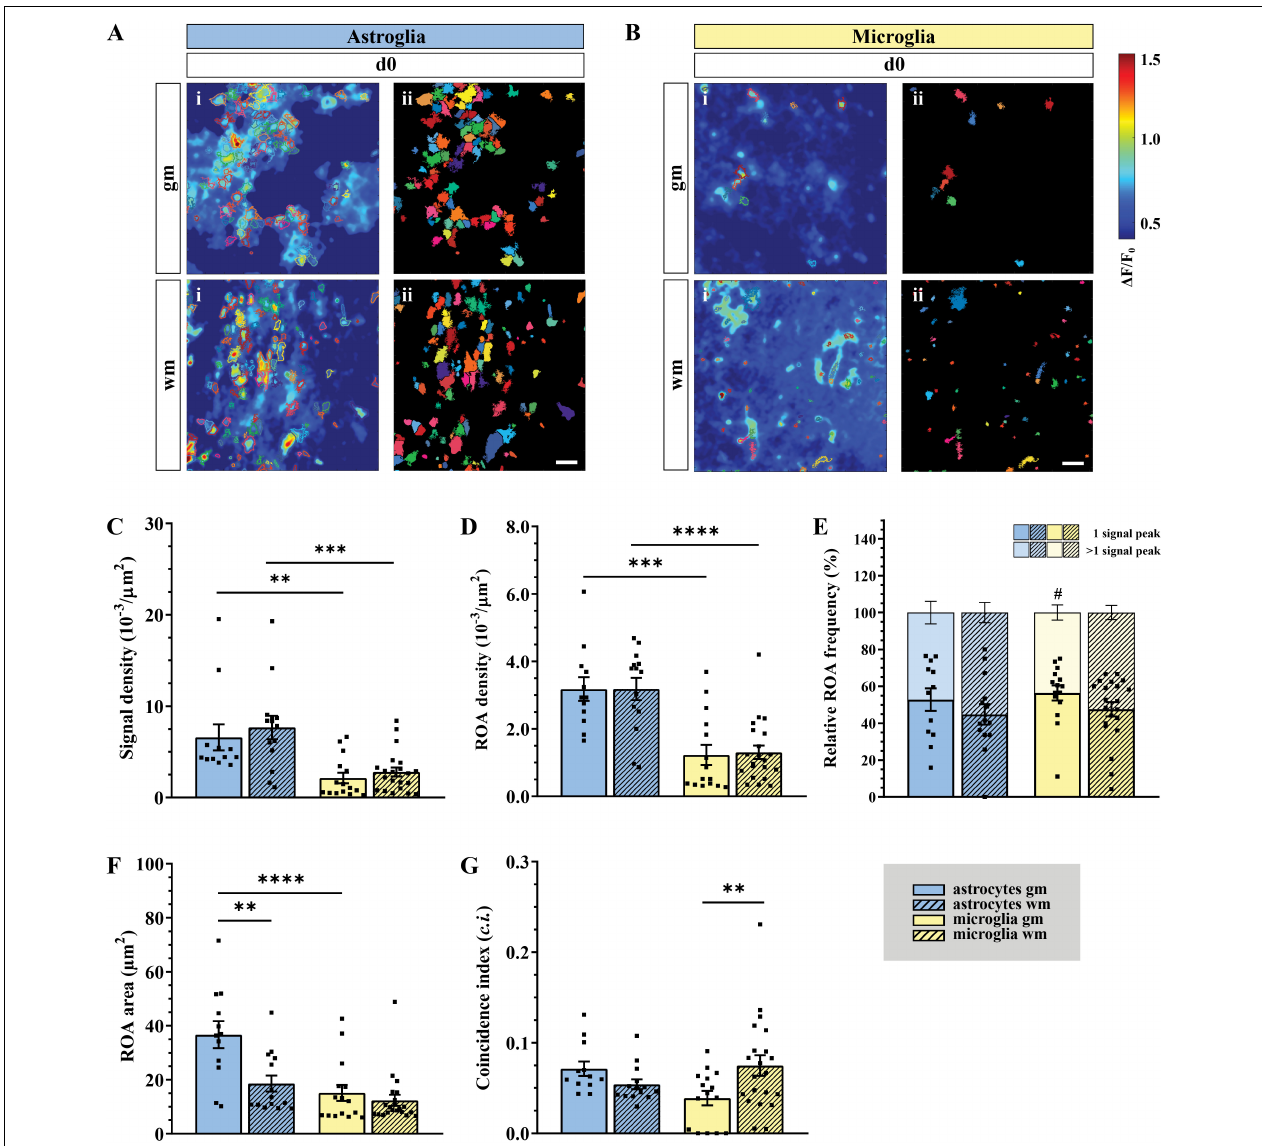
FIGURE 3 | Higher astroglial signal and ROA density in gray and white matter of acute slice preparations ( ex vivo ). (A,B) Automatic analysis of detected regions of activity (ROAs) based on absolute fluorescence projection along the temporal axis for astroglia [ (A) blue] and microglia [ (B) yellow] in gm and wm of acute slice preparations ( d0 ) with absolute fluorescence projections (i) overlapped with the edges of the detected ROAs [depicted as solid areas in panel (ii)]. (C) Signal and (D) ROA density in gm (solid) and wm (dashed). (E) Relative frequency of ROAs active once (lower bars) or more than once (upper bars) over the recording time. (F) ROA area and (G) mean relative number of simultaneously active ROAs over the total recording time calculated as coincidence index ( c.i. ). Data represented as mean ± SEM of single FOVs. Single datasets were analyzed using a Shapiro–Wilk normality test and represented as FOV medians. (C–G) Data were compared using an Ordinary one-way ANOVA with Bonferroni’s multiple comparisons test. For each group in panel (E) , the relative numbers of ROAs presenting one or more signal peaks were analyzed using a Wilcoxon matched pairs signed rank test. N (animals) = 4 (astroglia), 5 (microglia, gm ), 6 (microglia, wm ). n (FOVs) = 12 (astroglia, gm ), 14 (astroglia, wm ), 15 (microglia, gm ), 22 (microglia, wm ). , # p < 0.05; ∗∗ p < 0.01; ∗∗∗ p < 0.001; ∗∗∗∗ p < 0.0001.